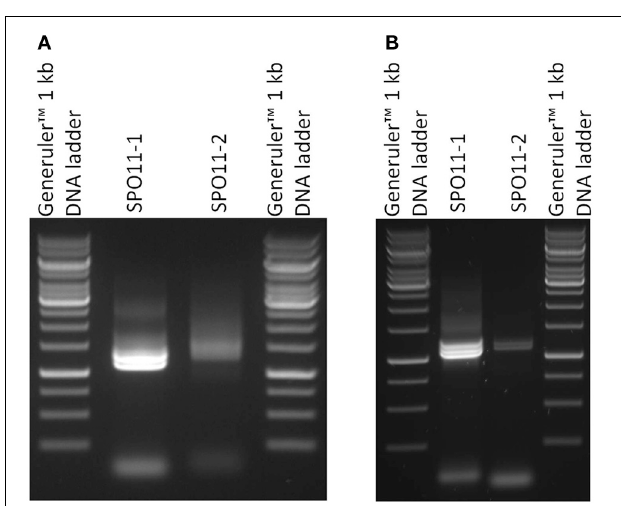
FIGURE 1 | The in-scale exon–intron organization of SPO11-1 (A) and SPO11-2 (B) for five analyzed species. Ath, Arabidopsis thaliana ; Bra, Brassica rapa ; Cpa, Carica papaya ; Ppa, Physcomitrella patens ; Osa, Oryza